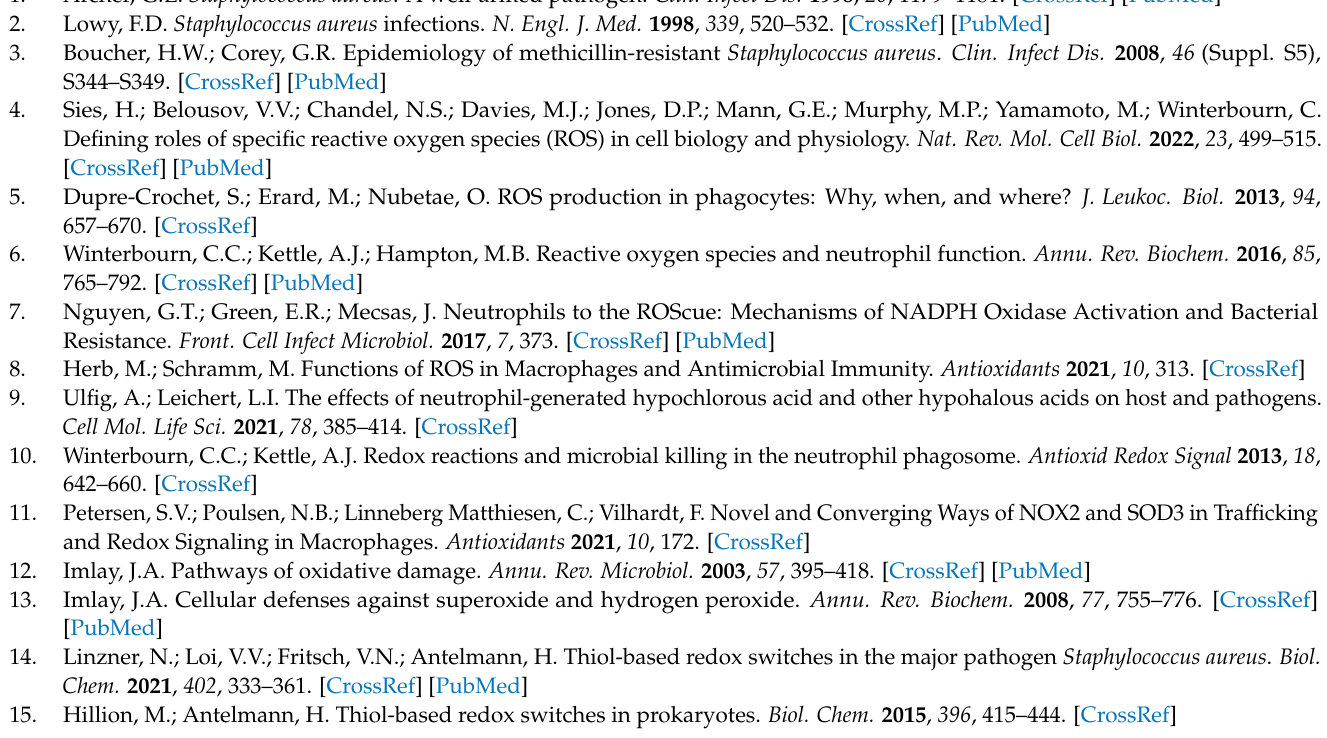
Figure S13: Native gels of catalase stains used for KatA activity assays (images of Figure S2B; three bioreplicates). Table S1: Bacterial strains; Table S2: Plasmids; Table S3: Oligonucleotide primers. Table S4: CFU counts for the H 2 O 2 survival assays. Table S5: CFU counts for microaerophilic H 2 O 2 priming. Table S6: CFU counts for aerobic H 2 O 2 priming. Table S7: CFU counts for the CHP survival assays. Table S8: CFU counts for HOCl survival